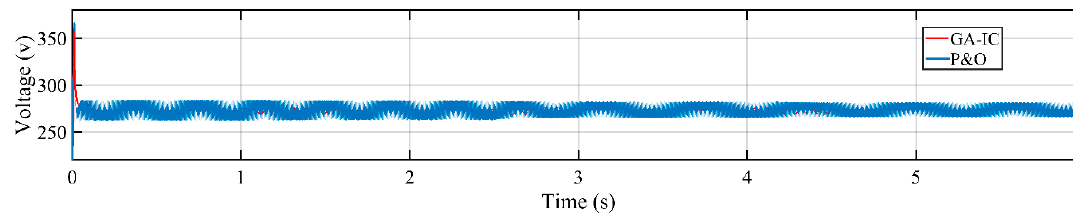
Figure 25. Case 2 power, detailed comparison of modified GA-IC vs. P&O.